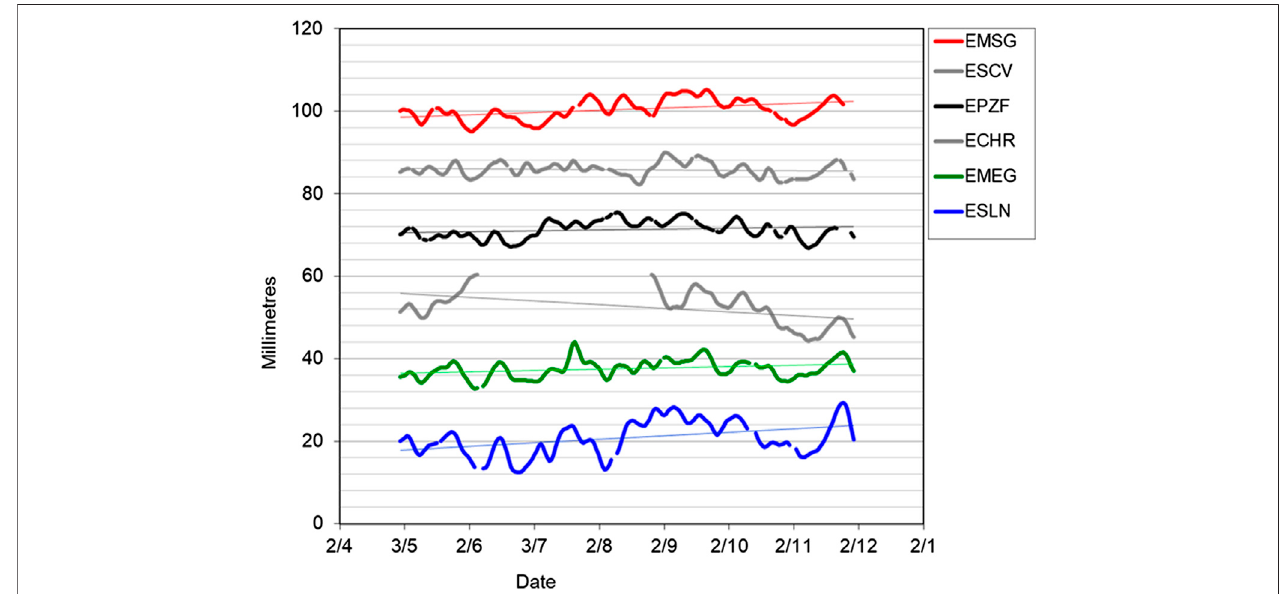
FIGURE 11 | GPS LOS displacement time series of the stations located in the western fl ank of Mt. Etna and their linear trends. For the distribution of the stations refer to Figure 2 .